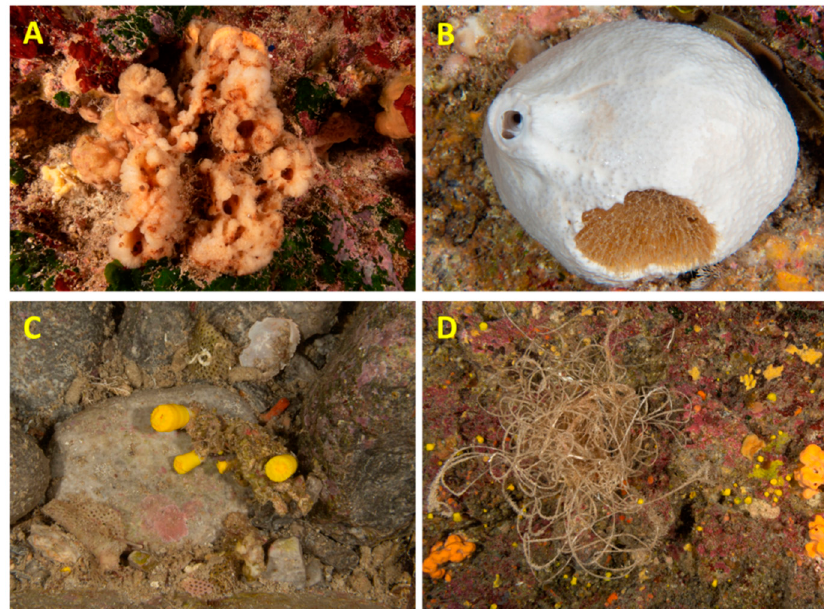
Figure 5. Partial necrosis of the sponges Agelas oroides ( A ) and Ircinia oros ( B ) from the entrance zone of Panteleimonas and Oxonisos caves, respectively; fragments of the coral Leptopsammia pruvoti and the erect bryozoans Myriapora truncata and Reteporella sp. ( C ); fishing line ( D ) attached to the walls at the semi-dark zone of Troulakas cave. Photos by T. Dailianis.